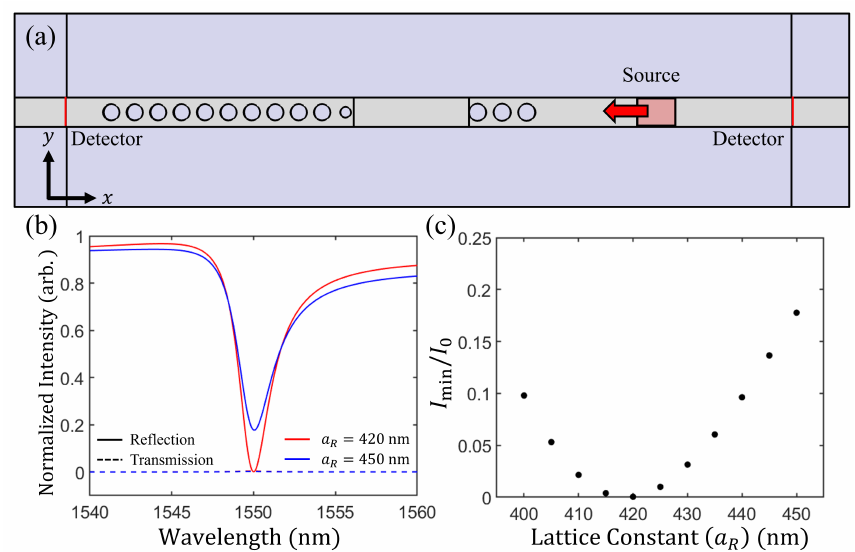
Figure 4. ( a ) Simulation configuration for CPL with the PMC-like boundary. Incident light with the y -axis electric field ( E y ) propagated to the resonator. Detectors at the left and right sides collect the Poynting vector of the x -axis of the transmitted and reflected light, respectively. ( b ) The intensity of the outgoing light from the resonator. The solid and dashed lines represent the reflected and transmitted lights, respectively. When the lattice constant ( a R ) of the PC on the right side of the resonator is 450 nm (blue line), the loss (in this situation, coupling loss) of the resonator is approx- imately 82%. The red solid line shows the loss for a lattice constant ( a R ) of 420 nm (red line). The loss reaches 100% at a wavelength of 1550 nm. ( c ) Intensity ratio I min / I 0 for the modified lattice constant of the PC acting as a coupler. For the lattice constant of approximately 420 nm, the I min / I 0 is approximately